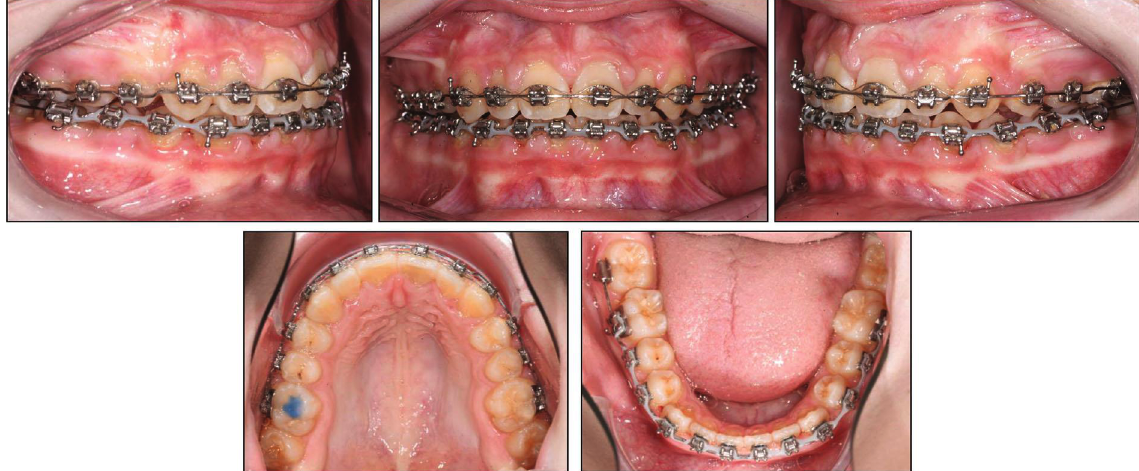
Figure 10: The patient ’ s intraoral photographs taken during orthodontic fi nishing with 0. 016 ″ × 0 : 022 ″ SS (Figure 15(b)). The superimposition of the mandibular trac- ings before and after treatment on the stable structures of the mandible (the protuberantia mentalis, the inner contour of